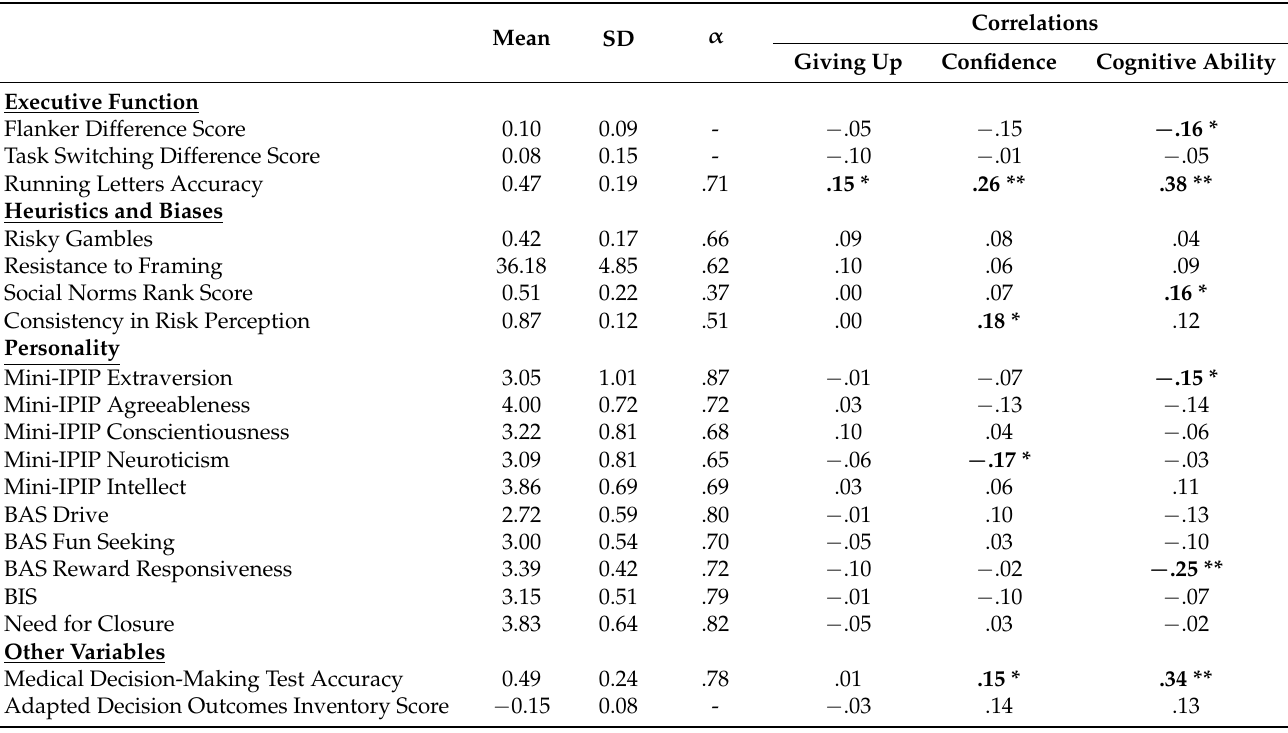
Table A2. Descriptive statistics, reliabilities, and correlations with factor scores of all other measured variables.